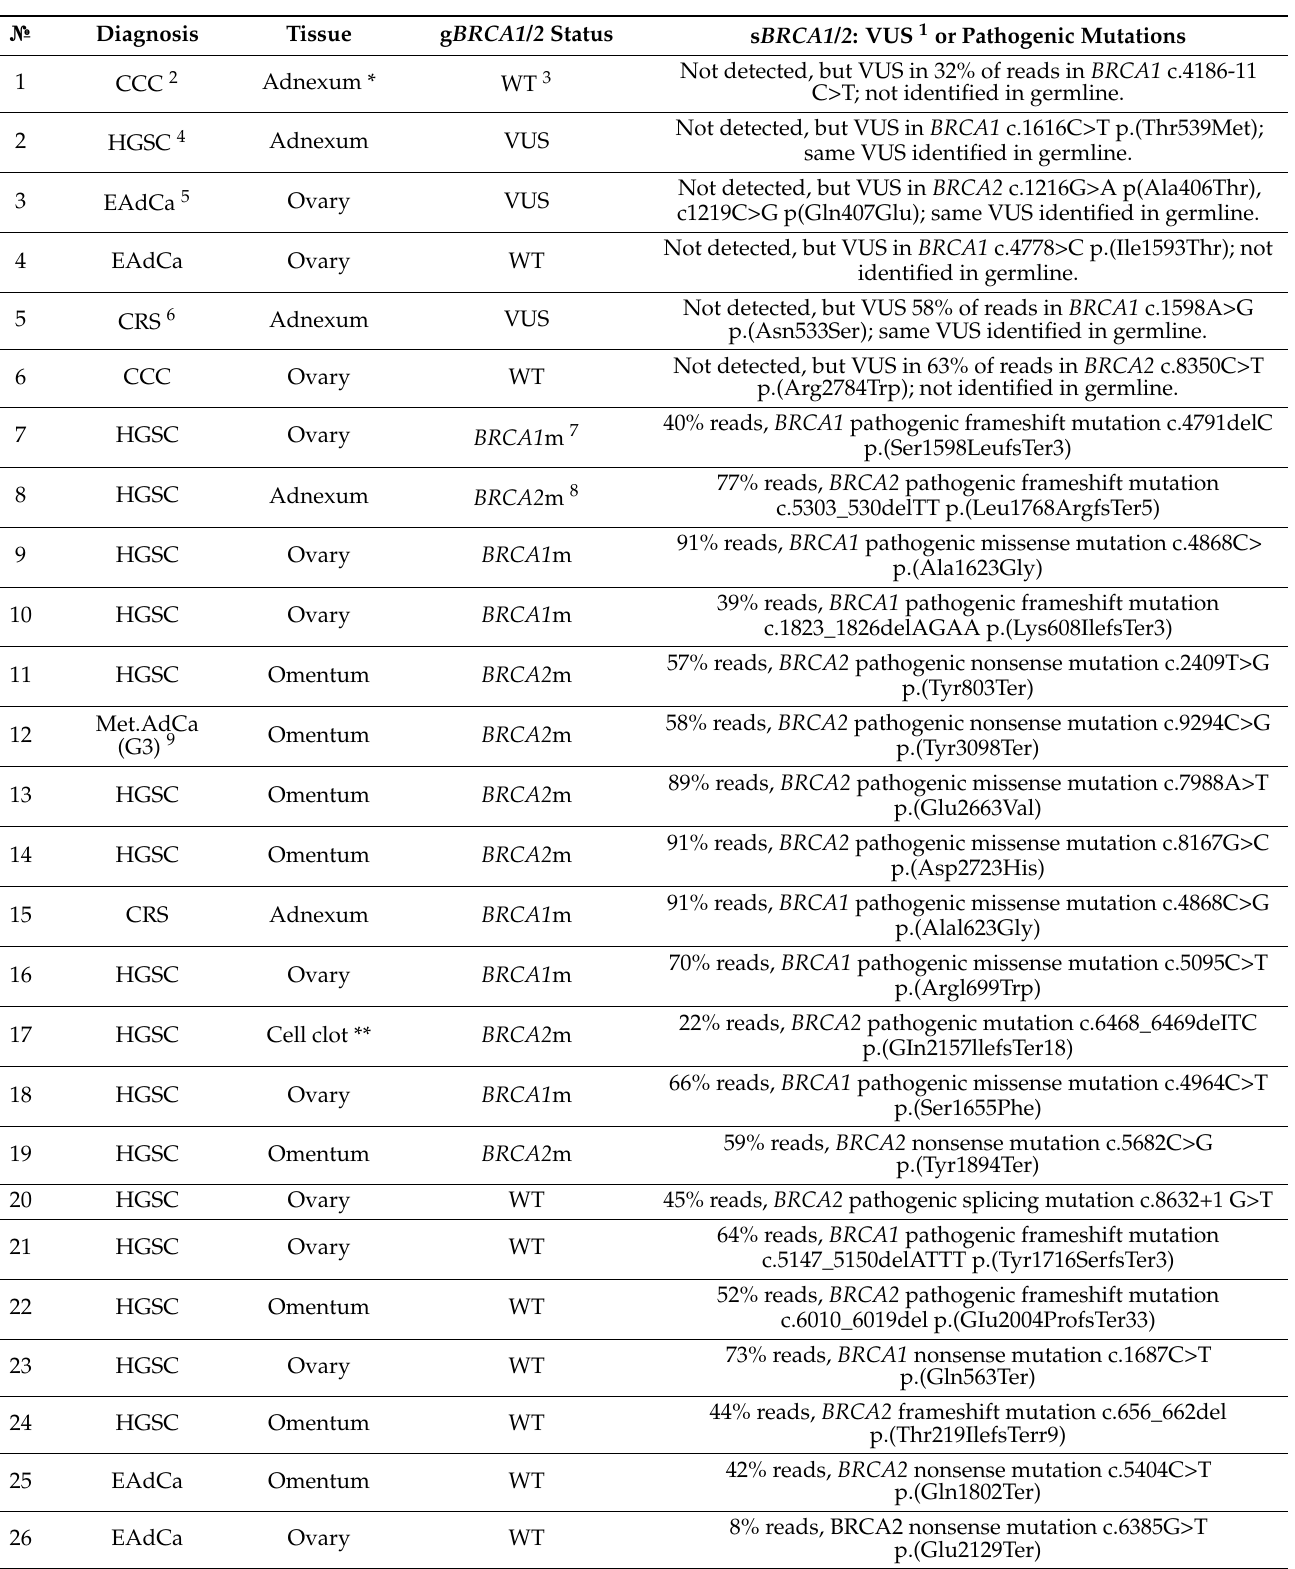
Table 2. Results from patients with detected variants of unknown significance (VUS) (samples 1–6), and pathogenic variants in g BRCA1/2 and s BRCA1/2 (samples 7–19), or s BRCA1/2 (samples